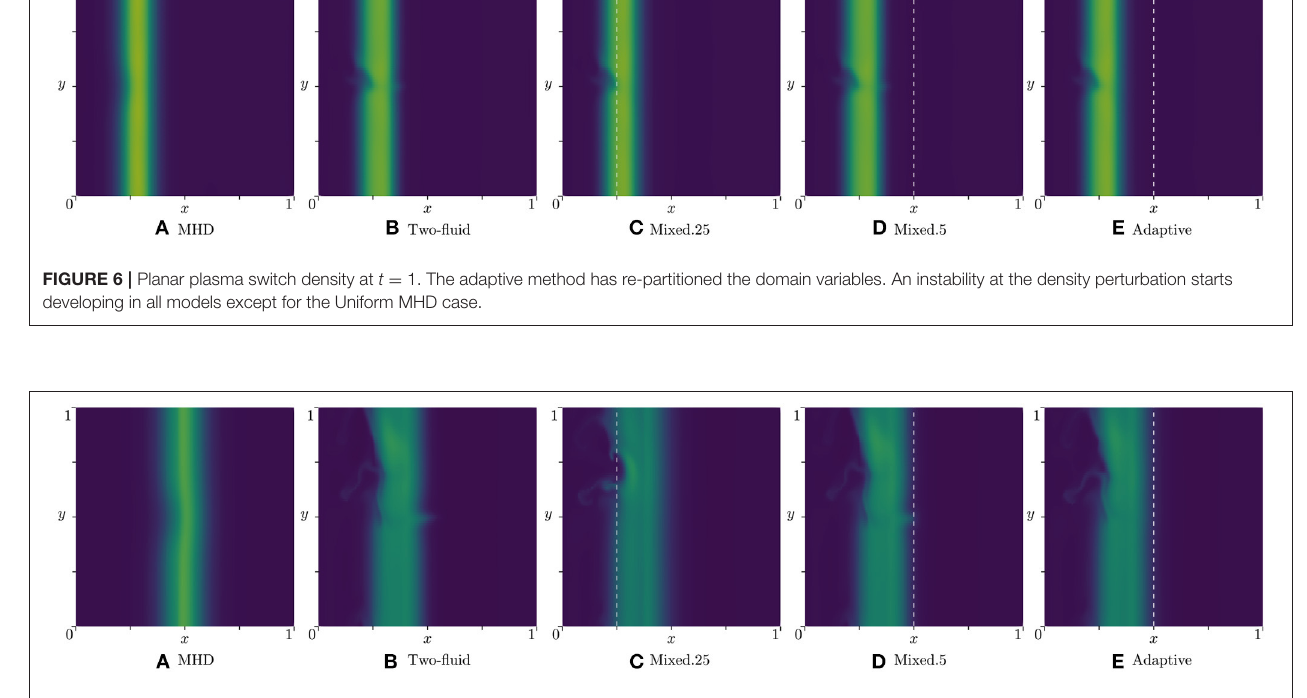
FIGURE 7 | Planar plasma switch density at t 2. The bulk plasma has transitioned past x 0.25 for all models. Some instabilities which have developed in the = = two-fluid region of the Mixed.25 case balloon on the MHD side, unlike the Uniform two-fluid or Mixed.5 cases. The adaptive method maintains similar instability structures as the Uniform two-fluid and Mixed.5